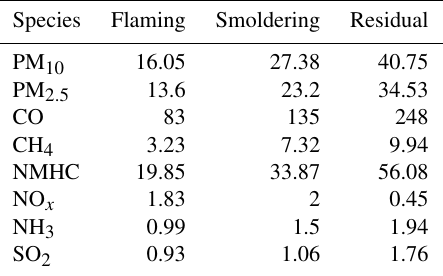
Table 3. Emission factors (gkg − 1 ) of species currently used in CF-